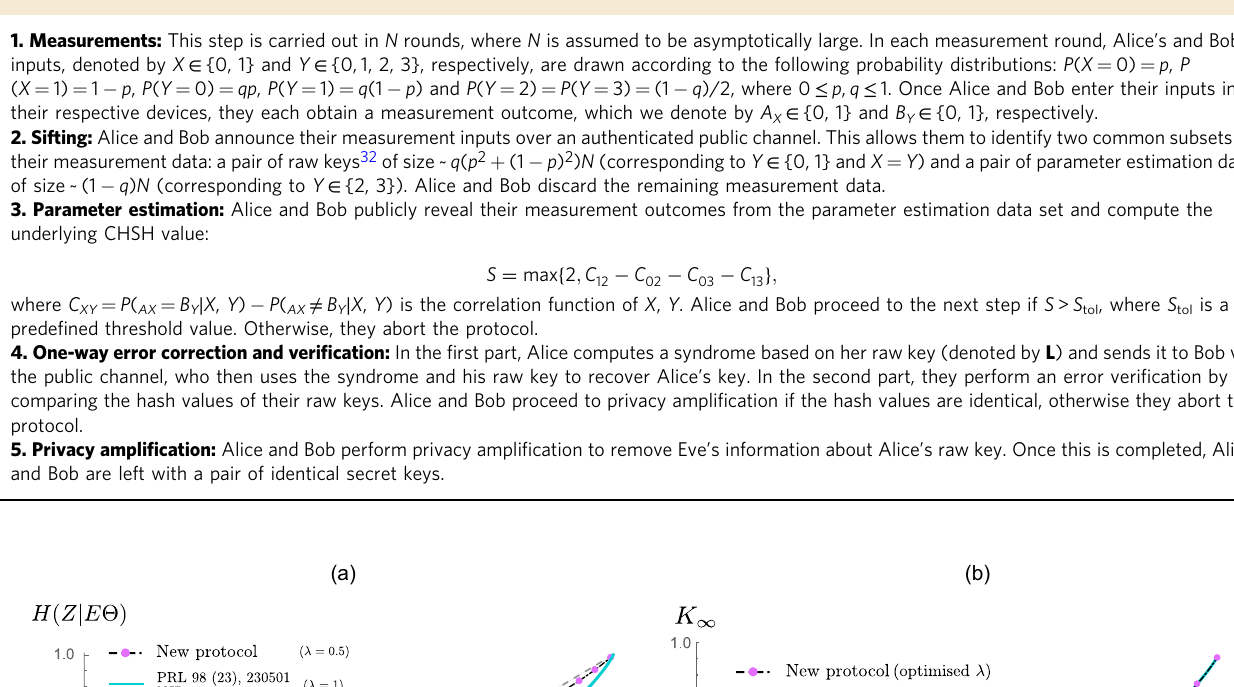
Box 1 | Proposed device-independent quantum key distribution protocol